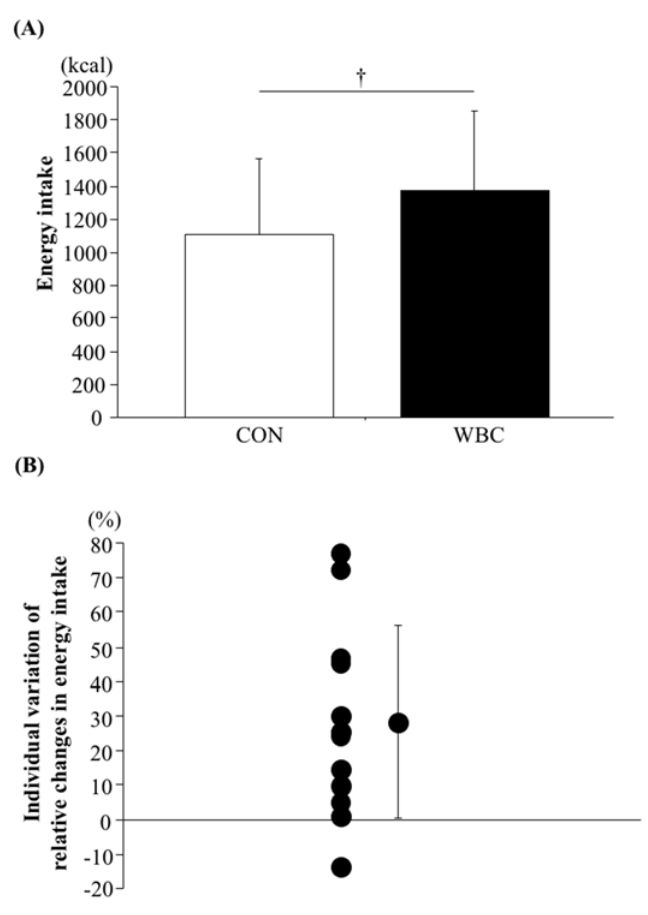
Figure 3. Energy intake ( A ) and individual variation of relative changes in energy intake ( B ) during ad libitum buffet meal test. The value ( B ) was calculated as relative increase (percentage of change) of energy intake in WBC trial (vs. CON trial). Above 0% (11 of 12 participants) means that energy intake was greater in the WBC trial than that in the CON trial (CON trial < WBC trial). Below 0% (1 of 12 participants) means that energy intake was greater in CON trial than that in WBC trial (CON trial > WBC trial). Values are means ± SD ( n = 12). † : p < 0.05 vs. CON. WBC: whole body cryotherapy; CON: rest period.